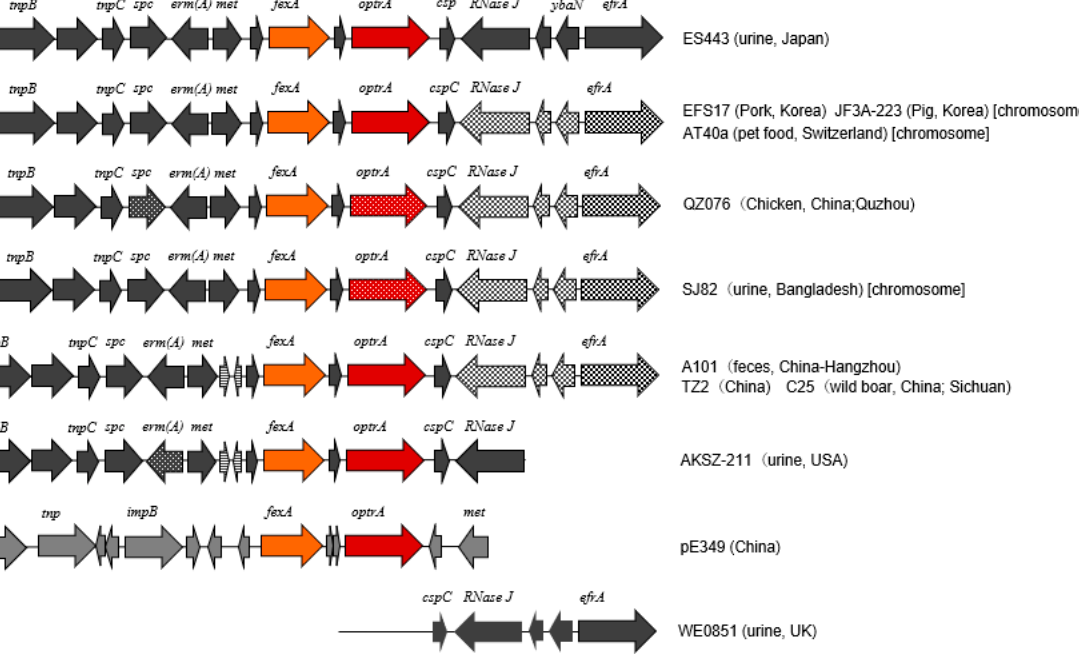
Figure 1. Schematic representation of the genetic background of optrA in E. faecalis isolate ES443 (uppermost) and the genetic organization or components similar to those of ES443 in other strains reported previously [25] or those available in the GenBank database. Prototype of the fexA–optrA cluster in the pE349 of E. faecalis strain E349 [24] is shown second from the bottom. Arrows indicate the transcription direction of genes. Different textures in arrows denote divergent sequences of genes. Gene names are shown above arrows, and the strain names are indicated on the right.